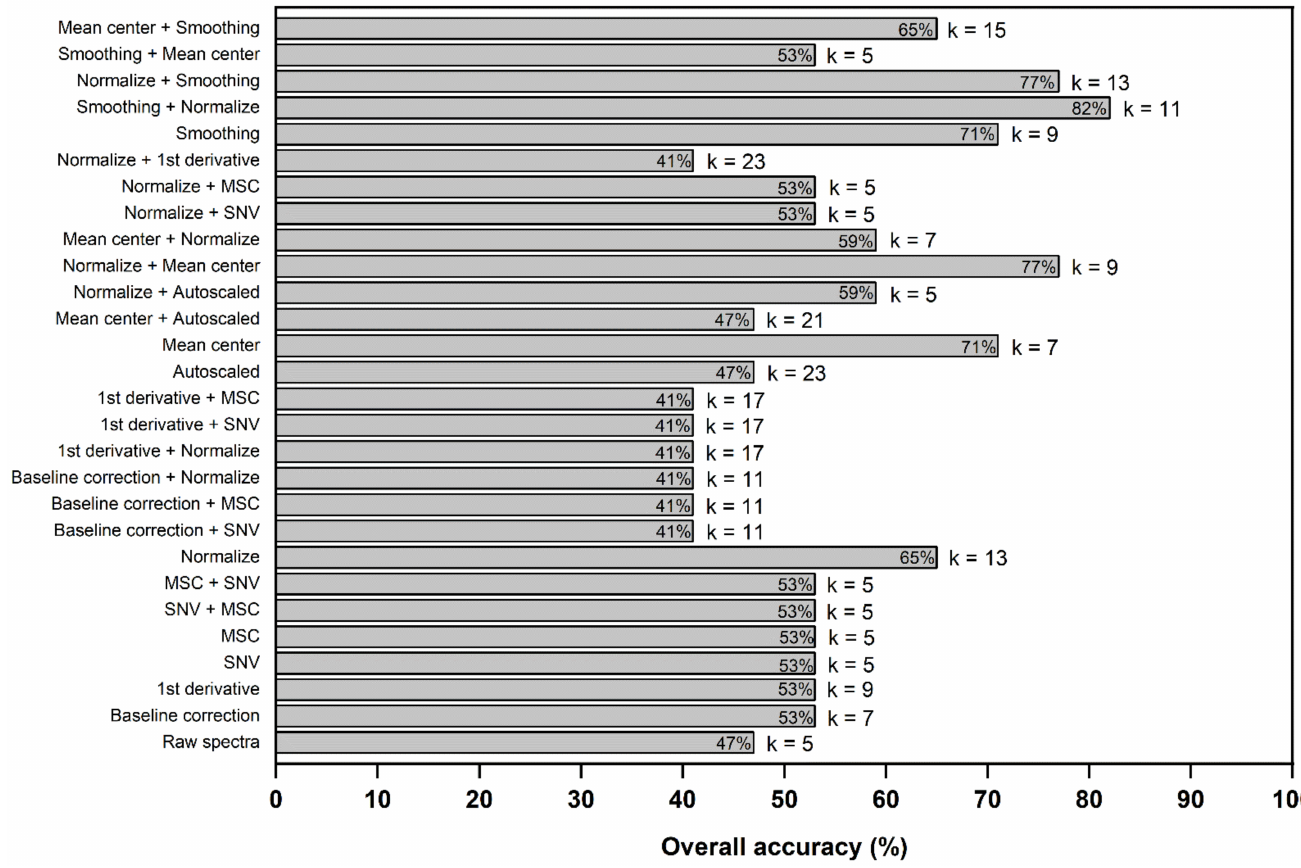
Figure 1. Evaluation of different spectral preprocessing for rice classification by k-NN